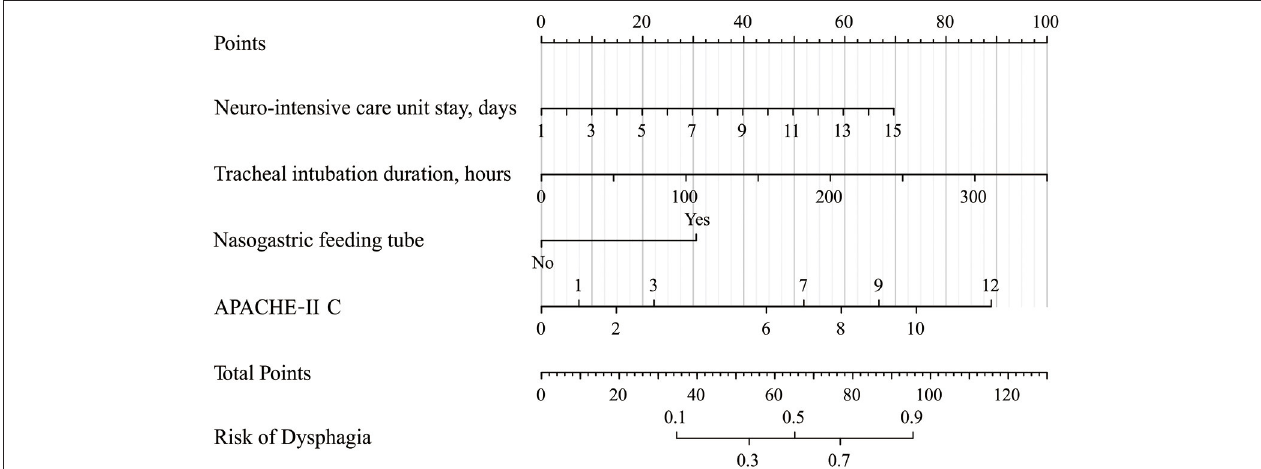
FIGURE 2 | Nomogram for predicting the risk of dysphagia. Points are assigned for NICU stay, tracheal intubation duration, nasogastric feeding tube, and APACHE-II C score. The “Points” displays prognostic points. The “total points” are calculated as the sum of the individual score of each variable, which is then used to find the appropriate position on the “Risk of Dysphagia” axis to determine the patient’s individual risk of dysphagia. For example, if one patient now stayed in NICU for 7 days (about 30 points), the tracheal intubation lasted for 35h (about 10 points), without the nasogastric feeding tube (0 points), the APACHE-II C score was 2 at admission (about 15 points), the total points for this patient were 55 points. The risk of dysphagia for this patient was about 33%. NICU, neurointensive care unit; APACHE-II, Acute Physiology and Chronic Health Evaluation.